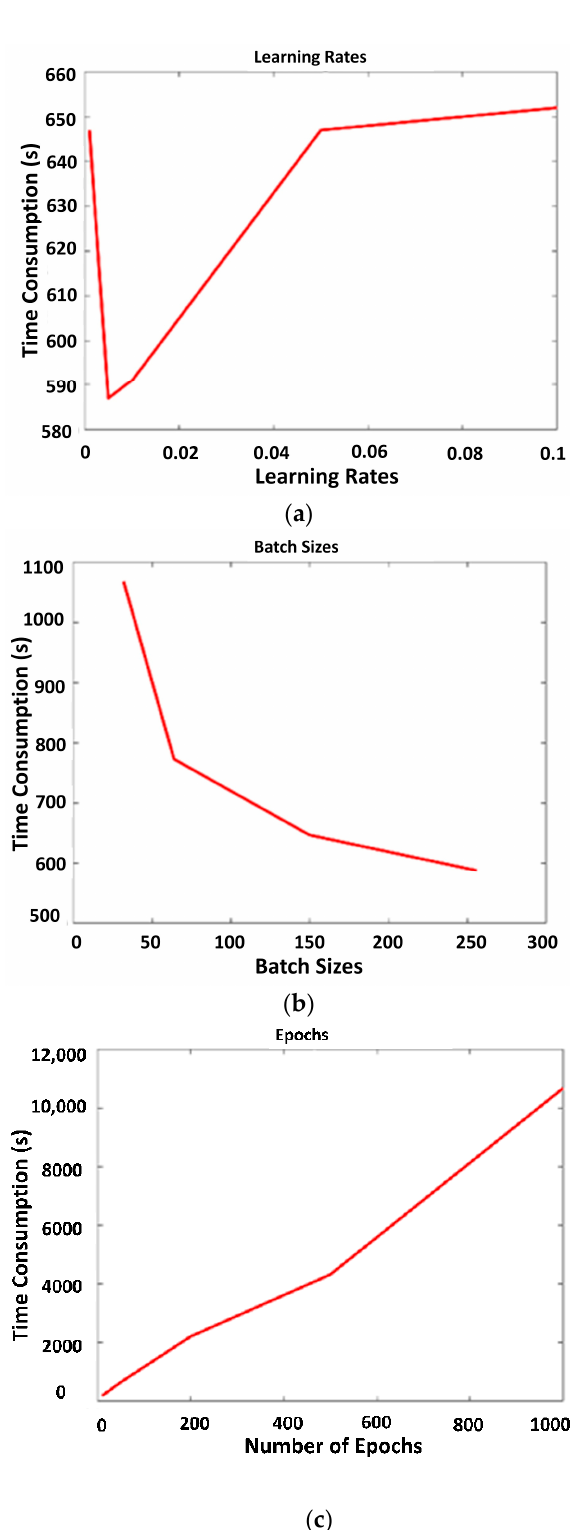
Figure 10. Time consumption for ( a ) learning rates, ( b ) batch sizes, and ( c ) number of epochs by implementing our Bi-LSTM model.